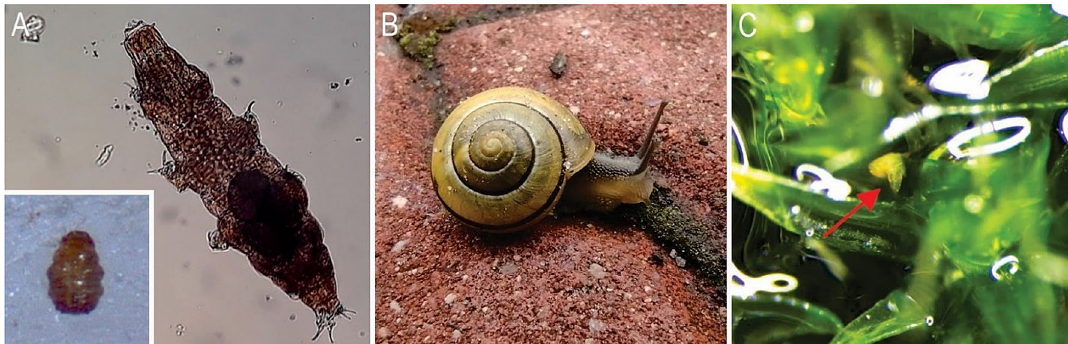
Figure 1. Model animals used in experiments: ( A ) Milnesium inceptum ; insert shows tardigrade in the tun state; ( B ) Cepaea nemoralis in its natural environment; ( C ) a tardigrade that appeared on moss surface during in vivo observation of rehydrated moss cushion (red arrow). Figures were assembled in Corel Photo-Paint 2017 (http:// www. corel.